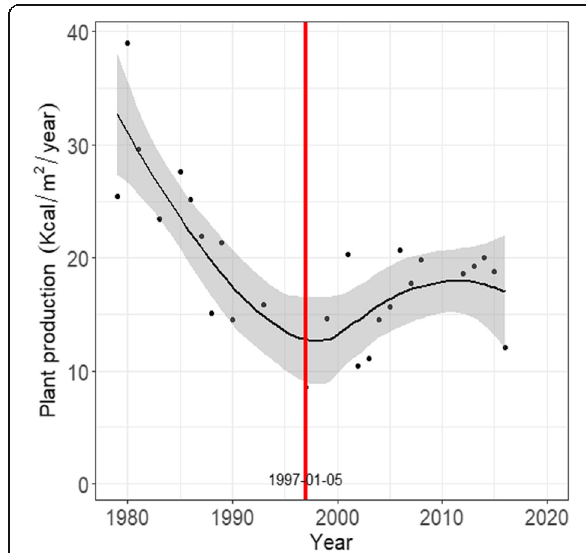
Fig. 7 Changes in production aggregated for trees, shrubs, and herbs combined for 20 permanent monitoring plots and all major Amboseli habitats. The red line shows the most significant changepoint. Annual growth rate is used as a proxy for